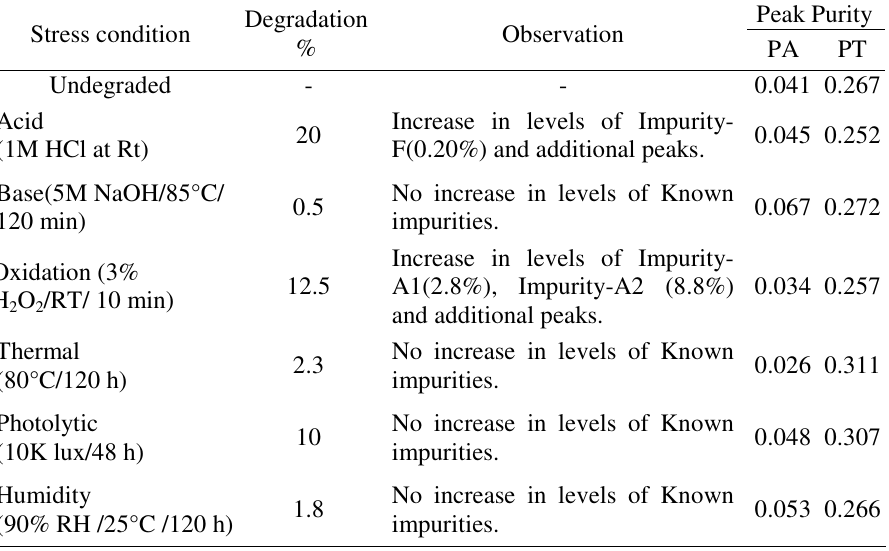
Table 3. Forced degradation studies